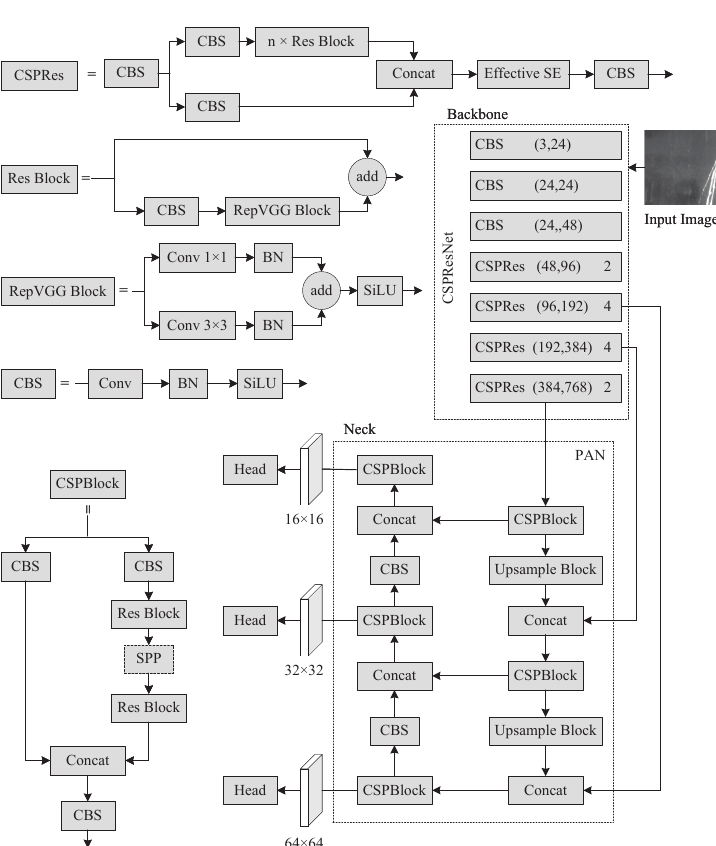
Figure 1. The PP-YOLOE-m network